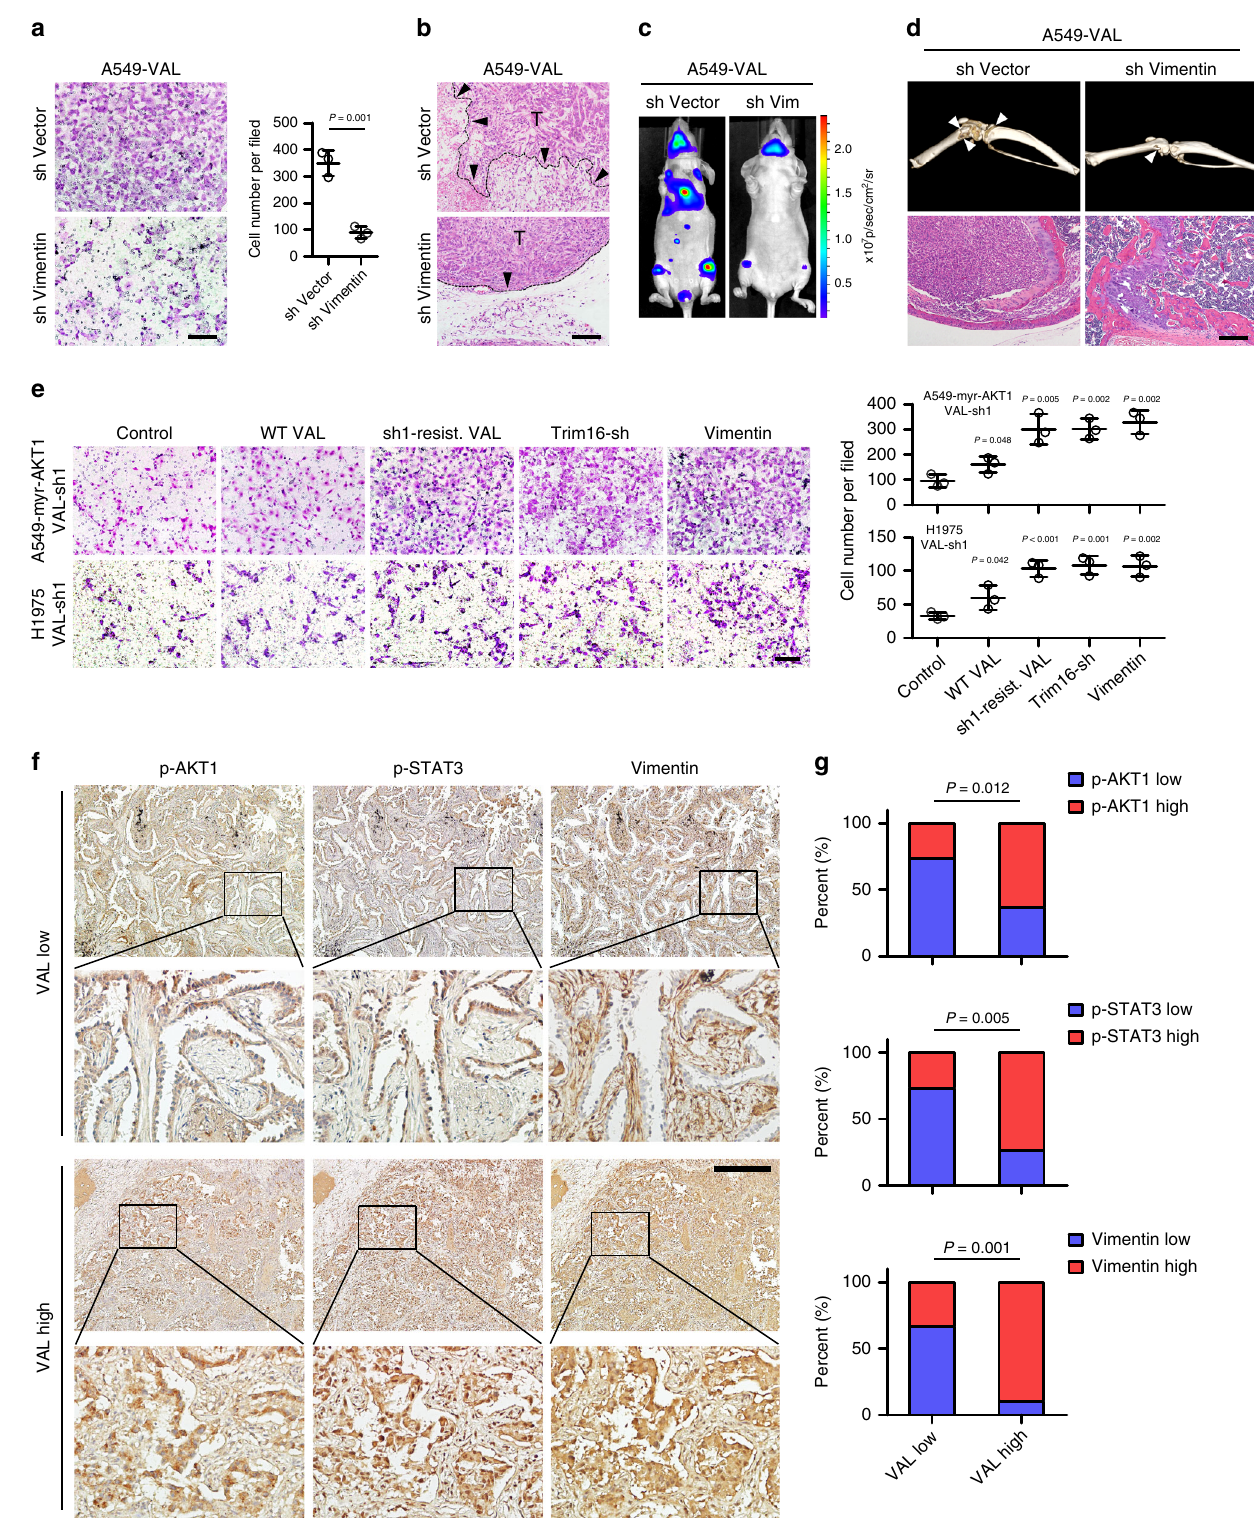
Statistical analysis . All statistical analyses except the sequencing data were per- formed using the PASW Statistics 18 version 18.0.0 (SPSS Inc., Chicago, IL, USA) software package and GraphPad Prism 8 version 8.3.0 (GraphPad Software, San Diego, CA, USA). Survival curves were analyzed by the Kaplan – Meier method and compared by the log-rank test. Comparisons between two groups were performed using Student ’ s t test (two-tailed), while analyses comparing multiple treatments with a control group were performed using two-way ANOVA with post hoc Dunnett ’ s multiple comparisons test. All error bars represent the mean±